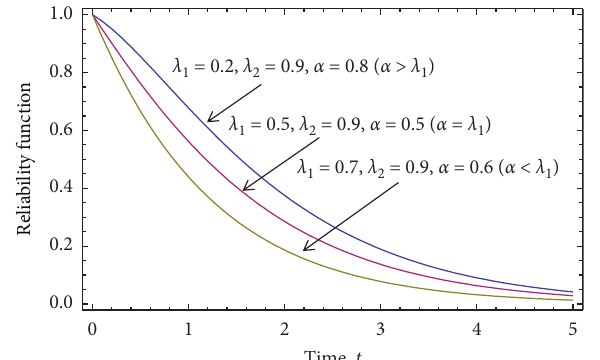
Figure 3: System reliability versus failure rate λ completion of warranty α .